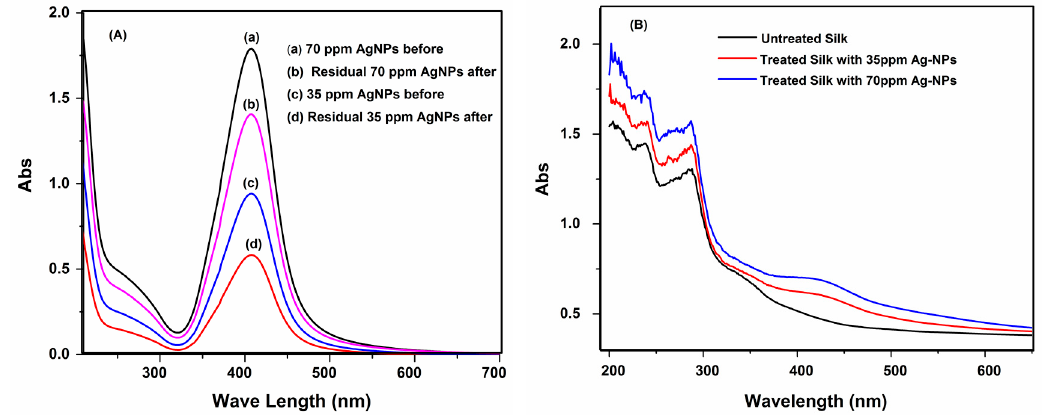
Figure 3. UV–vis spectra: ( A ) for residual Ag NPs solution with before and after treatment; and ( B ) the untreated and AgNPs-treated fabrics. untreated and AgNPs-treated